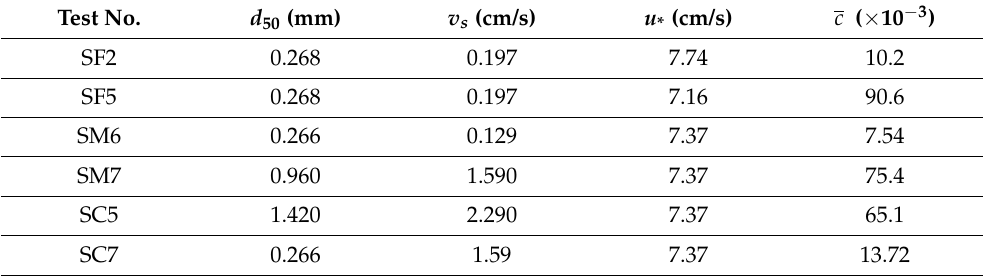
Table 4. Data by Wang and Qian [37]. Test